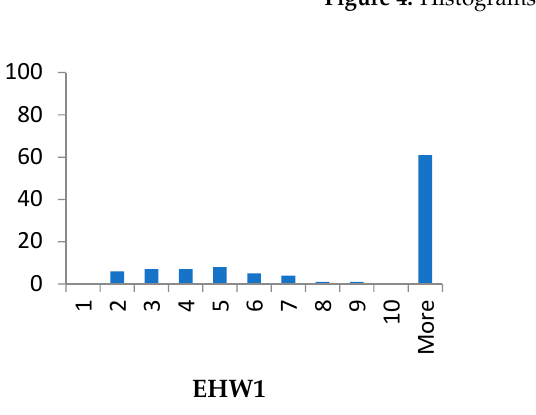
Figure 4. Histograms—benchmark instance A.